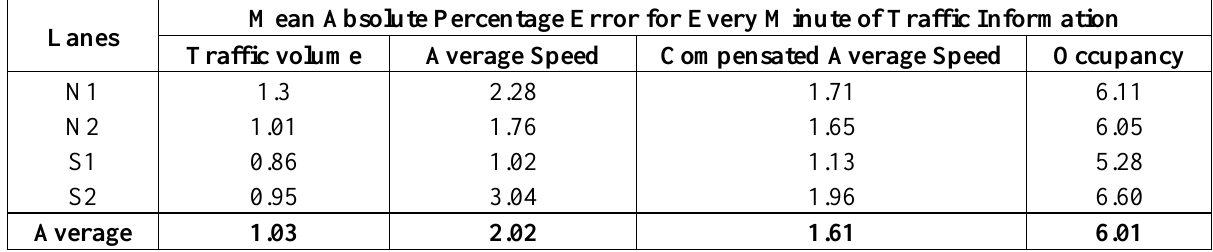
Table 6. Evaluation